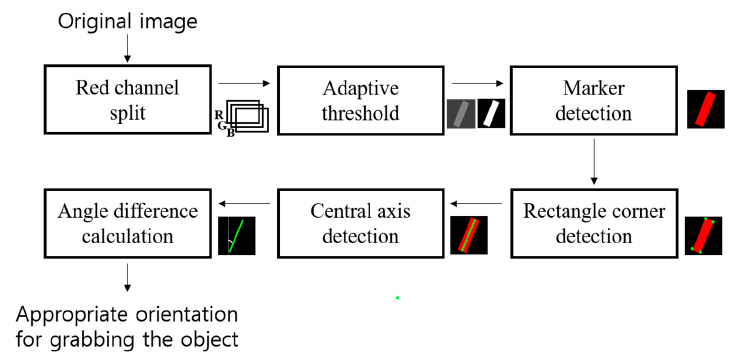
Figure 4. The image-processing algorithm for detecting the long axis of the target object using a red rectangular marker is shown.